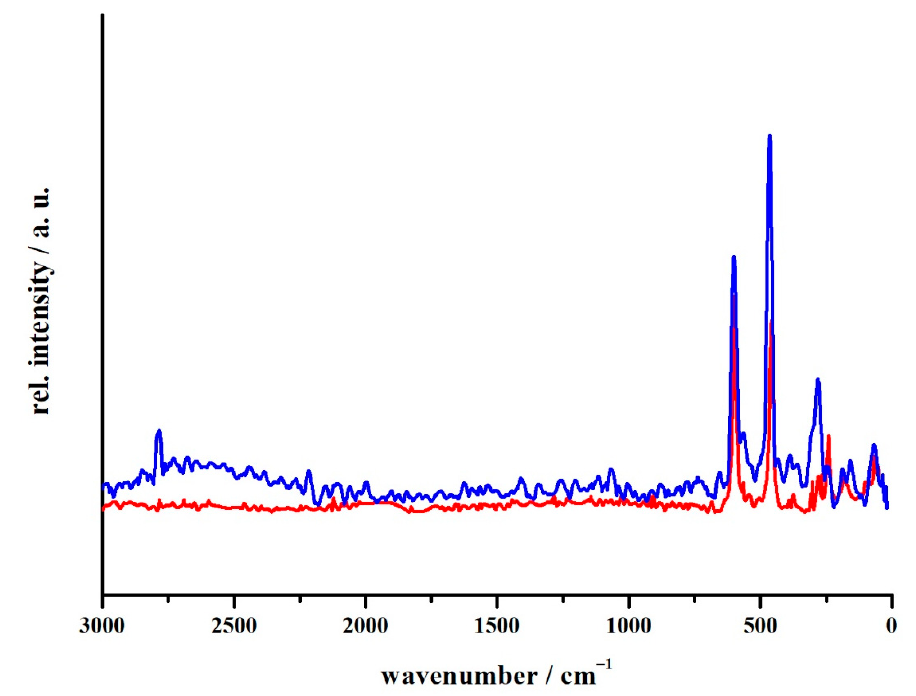
Figure 8. Raman spectra of K 2 AlF 5 -2 (blue) and K 2 AlF 5 -3 (red).